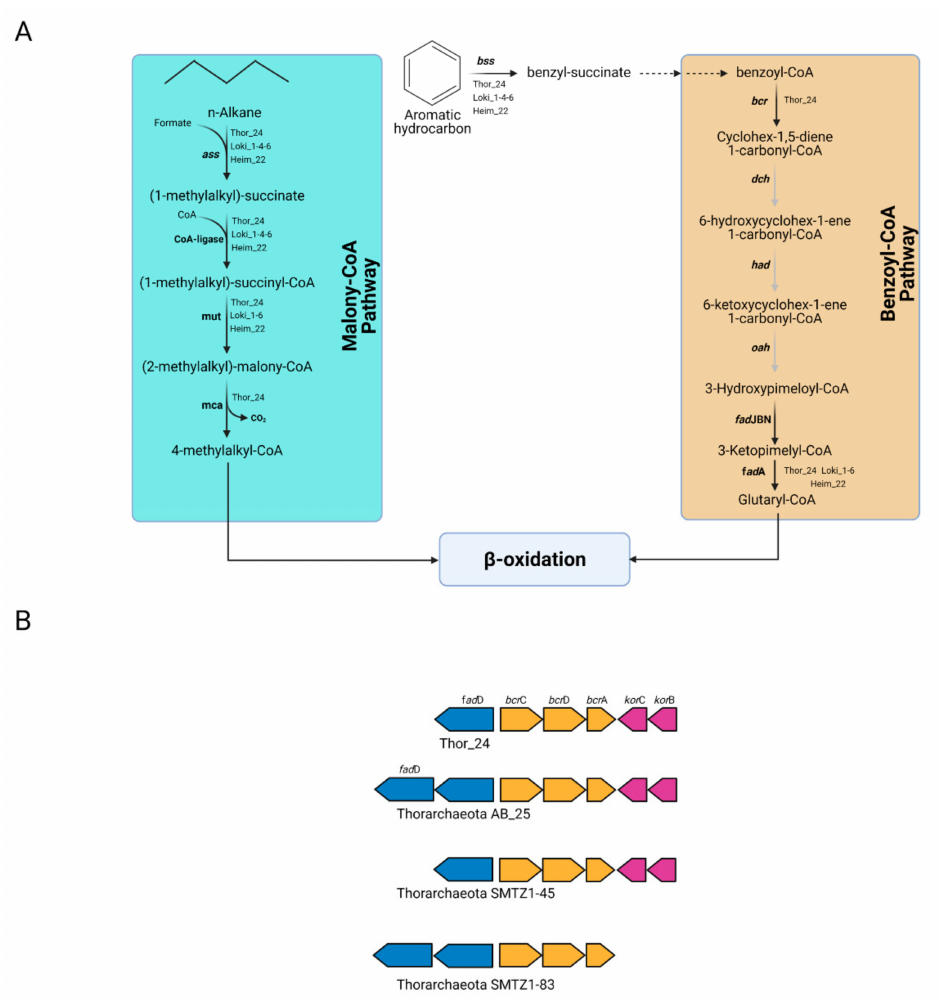
Figure 5. Metabolic pathways in Thorarchaeota, Lokiarchaeota, and Heimdallarchaeota bins involved in the degradation of aliphatic and aromatic hydrocarbons. ( A ) Malonyl-CoA and benzoyl-CoA pathways predicted in Thor_24 (Th24), Loki (Lk) and Heim (Hm) bins; gray arrows indicate that the reaction is not supported by the presence of the enzyme in the genome; genes involved in the pathways shown in this figure are reported in Table S3. ( B ) Gene cluster of the benzoyl- CoA-reductase genes (bcr) in Thor_24 and Thorarchaeota AB_25, SMTZ1-45, and SMTZ1-83. The Integrated Microbial Genome database was used identify bcr gene neighborhood of AB_25 (locus tag Ga197643_102918-102921), SMTZ1-45 (Ga0197632_115520-115514), and SMTZ1-83